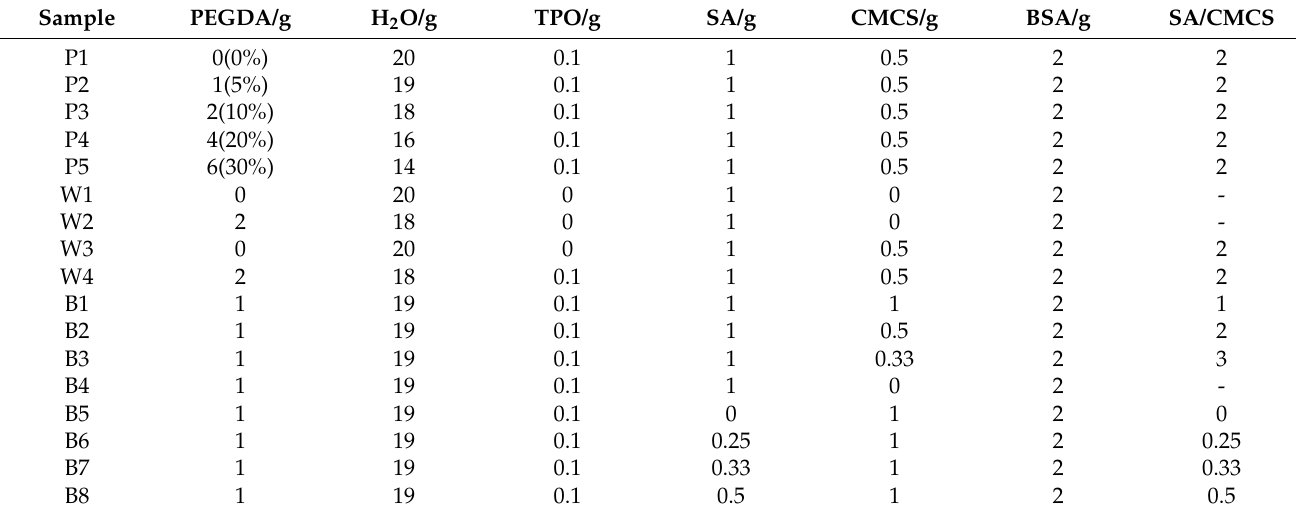
Table 1. Composition of the printing ink